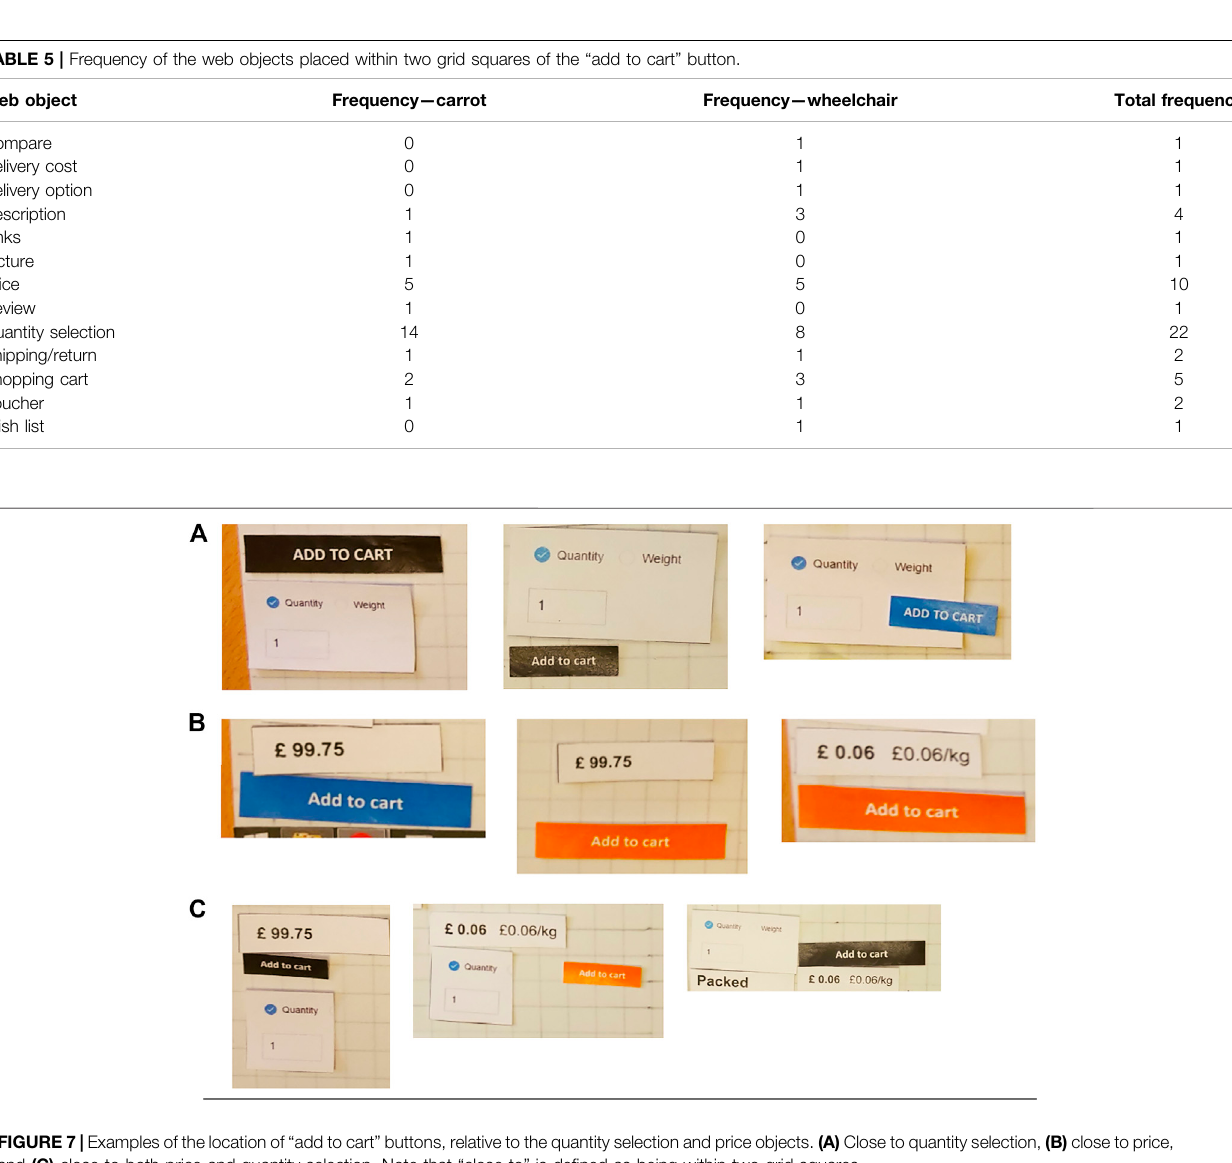
Frontiers in Computer Science |